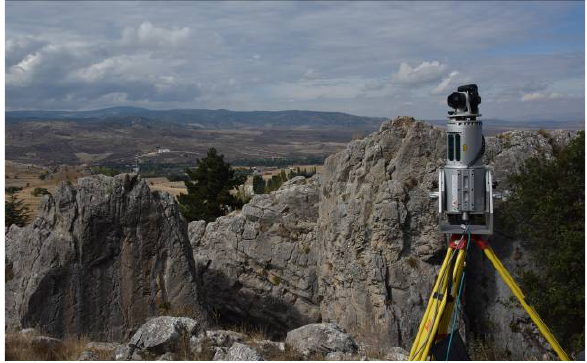
Figure 2. TOF-laser scanner activity in the Yazılıkaya